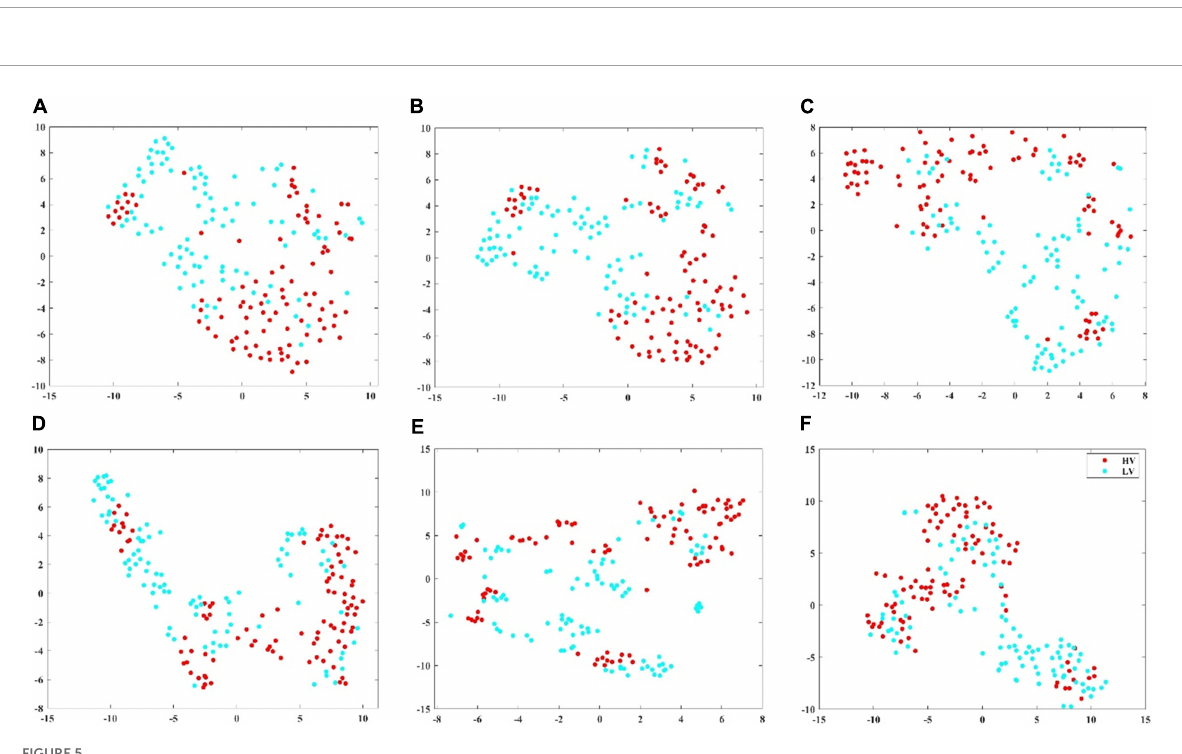
FIGURE5 Feature visualization map on DEAP dataset. (A) Second-order difference; (B) first-order difference; (C) fractal dimension; (D) gamma band power; (E) gamma band differential entropy; (F) gamma band CPL of coherence